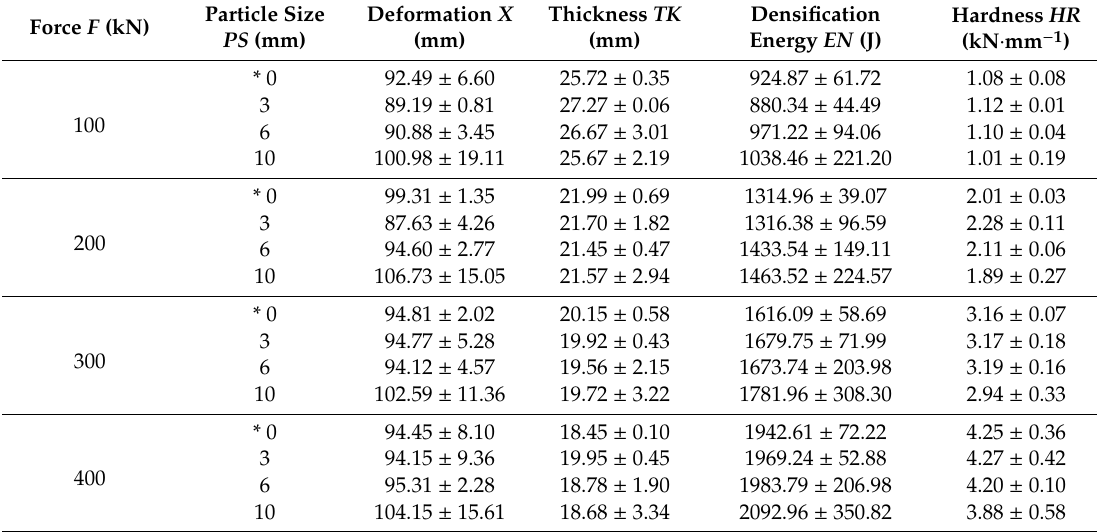
Table 1. Deformation, thickness, densification energy, and hardness of ground sunflower stalks with forces and particle